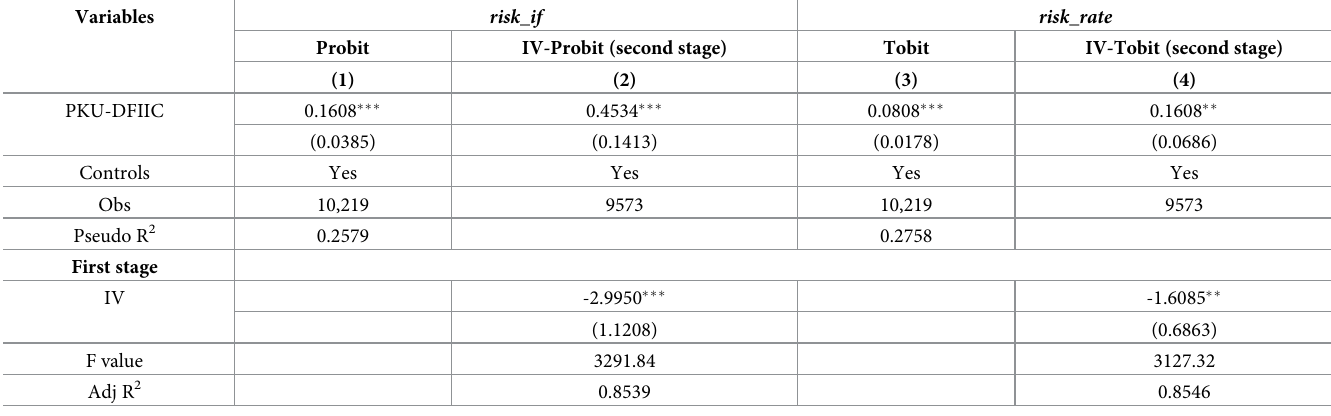
Table 2. Benchmark regressions of PKU-DFIIC on household participation in risky financial market and IV